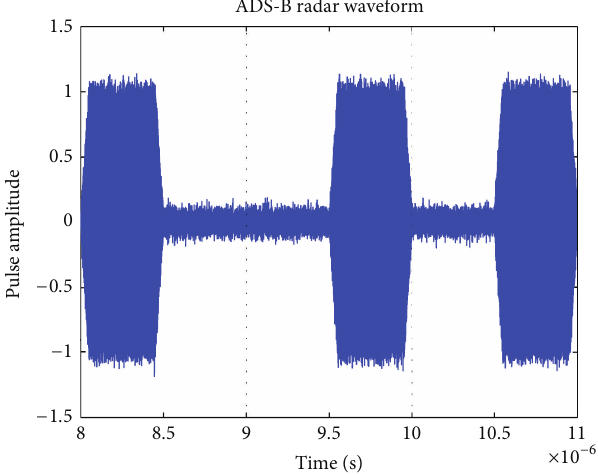
Figure 7: Transmitted ADS-B radar signal